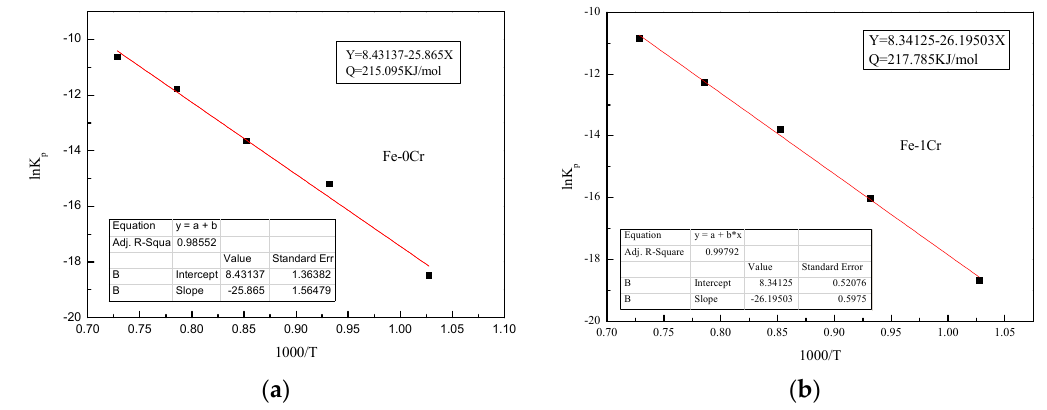
Figure 12. A fitting curve for steel (ln Kp vs. 1000/T). ( a ) Fe-1Cr; ( b ) Fe-0Cr.